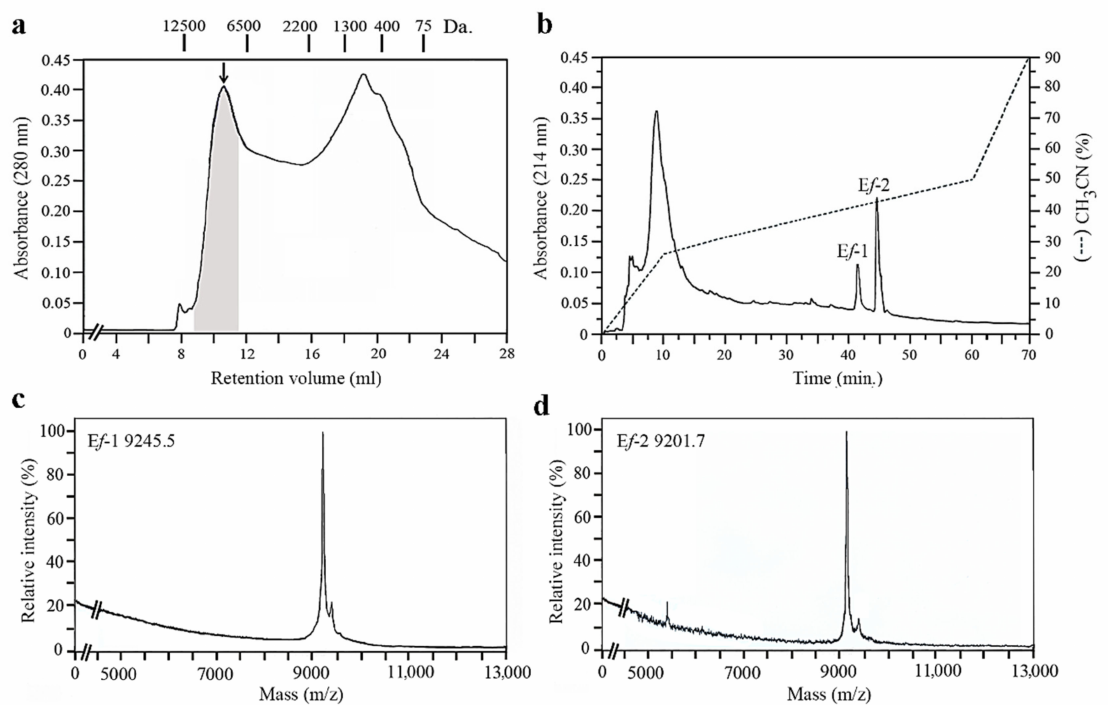
Figure 1. Purification and mass spectrometry of pheromones E f -1 and E f -2. ( a ) Elution profile of the gel filtration chromatography of the protein material adsorbed onto reverse-phase cartridges from cell- culture supernatant preparations. In the chromatogram, the shadowed area indicates the pheromone- containing fractions. The points of elution of proteins with standard molecular masses are indicated above the chromatogram. ( b ) Elution profile of the protein material pooled from the shadowed fractions and separated on reverse-phase chromatography. The applied acetonitrile gradient is indicated by a dotted line and the elution peaks of the two proteins identified as pheromones are labelled E f -1 and E f -2. ( c ) Molecular mass determination of pheromone E f -1. ( d ) Molecular mass determination of pheromone E f